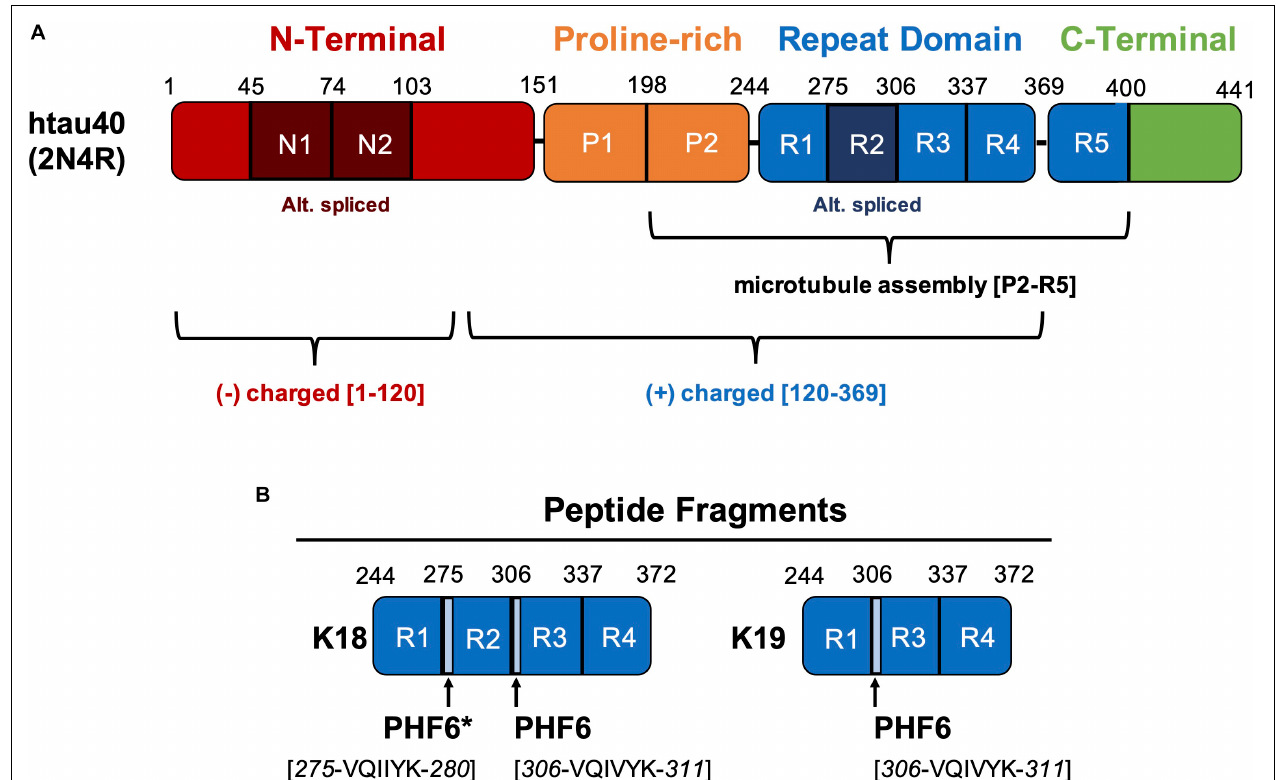
FIGURE 1 | (A) Tau consists of 4 domains – the N-terminal, proline-rich, repeat domain (RD), and C-terminal domain. Residues 1–120 of the N-terminal domain bear an overall negative charge while residues 120–369, including the RD, are overall positively charged. Sub-domains N1, N2, and R2 are alternatively spliced; R2 corresponds to exon 10 of the gene. The longest central nervous system isoform, htau40, consists of 441 amino acids and is also notated as 2N4R indicating the presence of both N1 and N2 as well as R1, R2, R3, and R4. The C-terminal part (repeat domain + flanking domains P2 and R5) can be considered as MT-assembly domain as it binds strongly to MT and promotes their polymerization. The N-terminal half (N + P1) does not bind to MT (aka projection domain). The repeat domain RD forms the backbone of Alzheimer filaments. (B) Tau-based peptide fragments commonly used as models for assembly of β -sheet rich structures. The K18 and K19 fragments contain domains R1-R2-R3-R4 and R1-R3-R4 respectively. The hexapeptides PHF6 and PHF6* promote the assembly of β